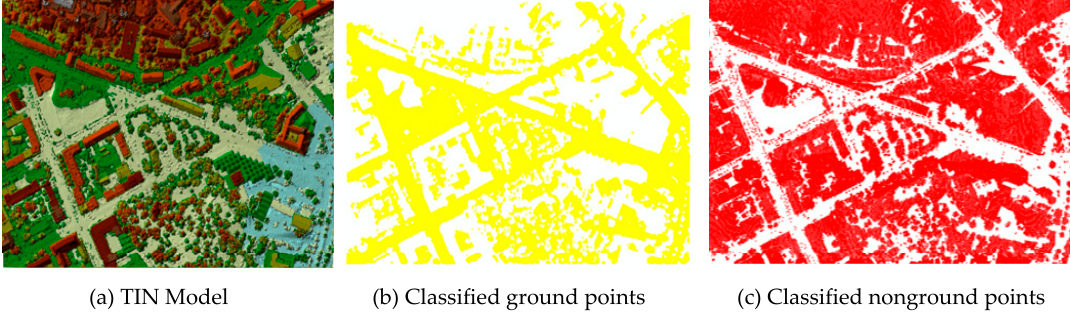
Figure 11. ISPRS sample 3 for testing contour line